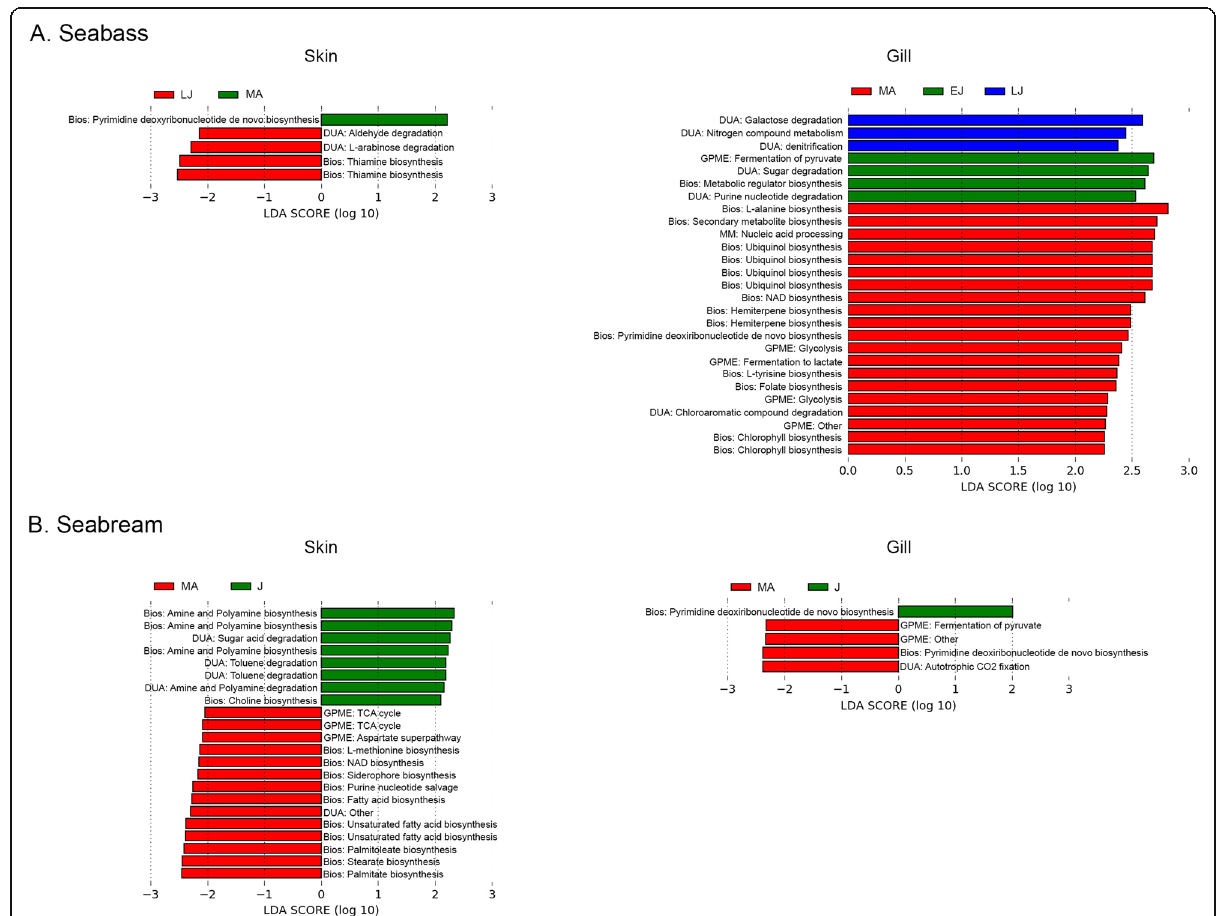
Fig. 4 LDA score of differentially abundant enriched pathways in the skin and gill microbiota of early juveniles (EJ), late juveniles (LJ), juveniles (J) and mature adults (MA) of seabass Dicentrarchus labrax ( a ) and seabream Sparus aurata ( b ). Bios: Biosynthesis; DUA: Degradation/Utilization/ Assimilation; GPME: Generator of Precursor Metabolites and Energy; MM: Macromolecule Modification